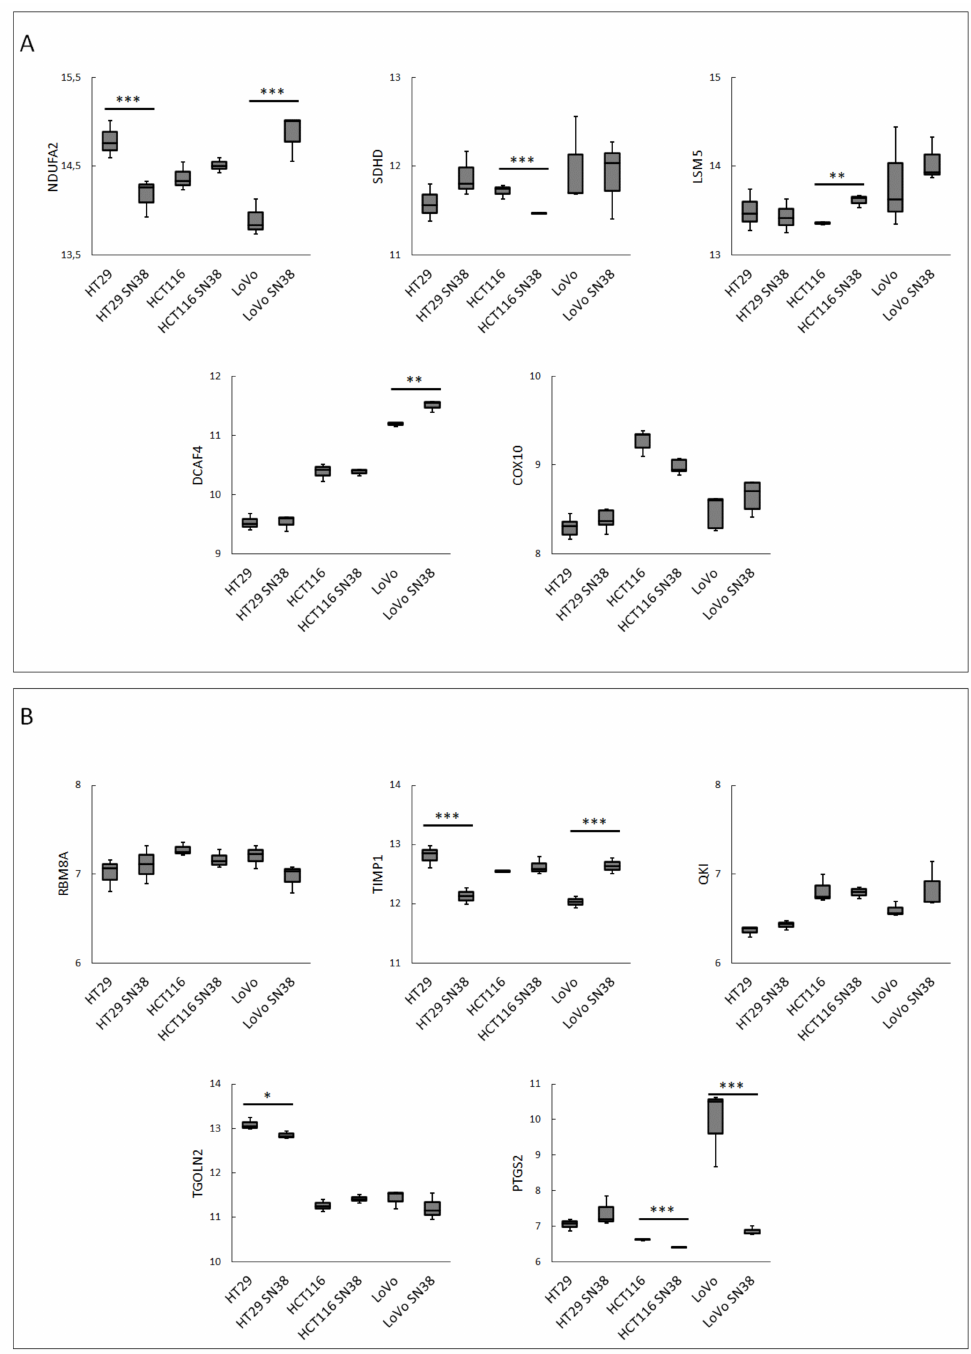
Figure 4. The mRNA expression levels in CRC cell lines of the 5 top networking up- ( A ) and down- ( B ) regulated DEGs from FOLFIRI-resistant patient cohort. Data were obtained using the GOE database: GSE42387 (GPL16297 Agilent-014850 Whole Human Genome Microarray 4x44K G4112F platform). Normality test (Shapiro–Wilk’s) followed by Mann–Whitney U test (for not normally distributed data) or T-test (for normally distributed data); * p > 0.05, ** p > 0.005, *** and p >